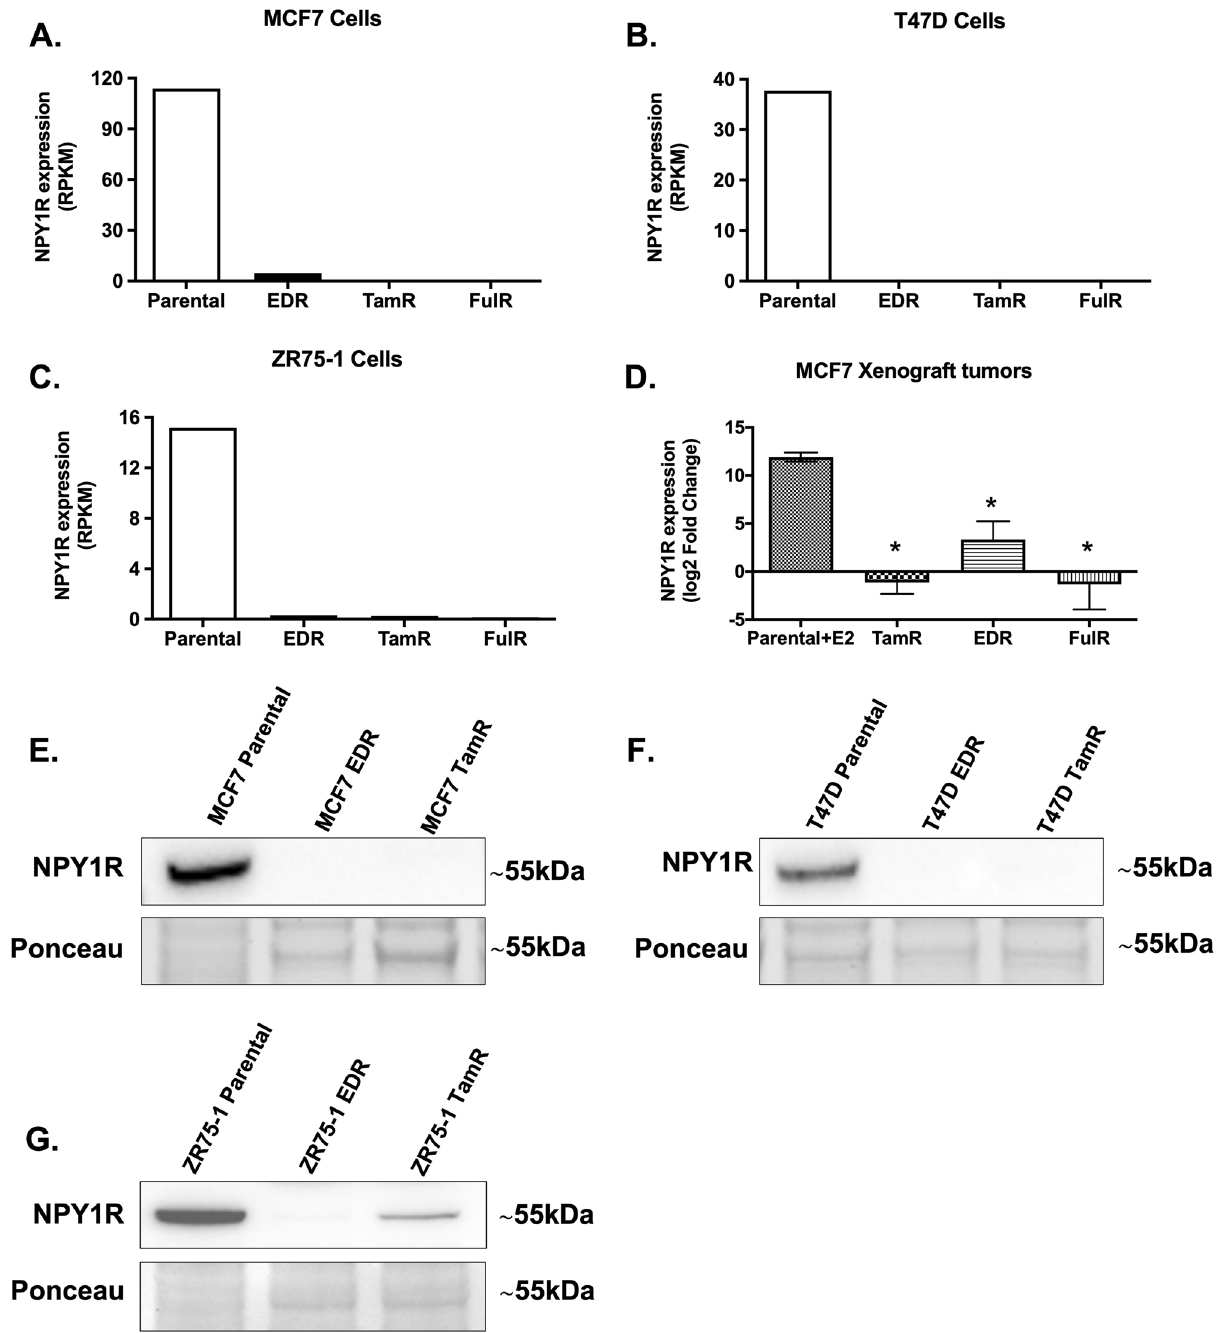
Figure 4. NPY1R gene and protein expression is impaired in endocrine-resistant derivatives of ER+ BC cells in vitro and downregulated in tamoxifen-resistant xenograft tumors in vivo. RNA-Seq data of parental and their estrogen deprivation-resistant (EDR), tamoxifen-resistant (TamR), and fulvestrant-resistant (FulR) derivatives of ( A ) MCF7, ( B) T47D, and ( C ) ZR75-1 cells were interrogated 38 . Data were plotted as Reads Per Kilobase of transcript per Million mapped reads (RPKM). ( D ) U133plus2 Affymetrix Chip array data from MCF-7 tumors derivatives of EDR, TamR, and FulR, alongside parental tumors in presence of continued estrogen supplementation (E2) was evaluated and plotted as RNA Express-calculated signal intensity (log2 transformed fold change) 36,37 . *indicates p < 0.05 by One-way ANOVA, Dunnett’s test (n = 3–4). The protein expression of NPY1R was compared in MCF7, T47D and ZR75-1 parental cells to their EDR and TamR derivatives. Representative immunoblotting images showing the protein expression of NPY1R in ( E ) MCF7, ( F ) T47D and ( G ) ZR75-1 parental cells and their EDR and TamR derivatives. Ponceau staining was used to assess equal protein loading for visual assessment. The densitometric quantitation of the relative intensity of NPY1R to parental cells (from three independent experiments) is shown in Supplementary Fig. 5. Full-length blots are presented in Supplementary Fig.